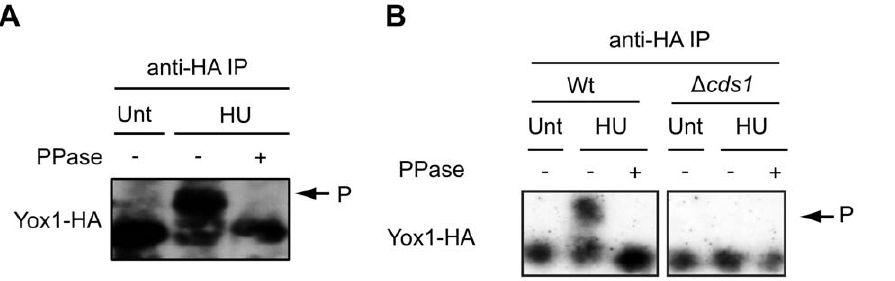
Figure 4. Yox1p HU-induced phosphorylation is Cds1p dependent. (A and B) Yox1-HA in WCE and HA-enriched lysates deriving from untreated and HU-treated cells detected by high-affinity anti-HA antibody.